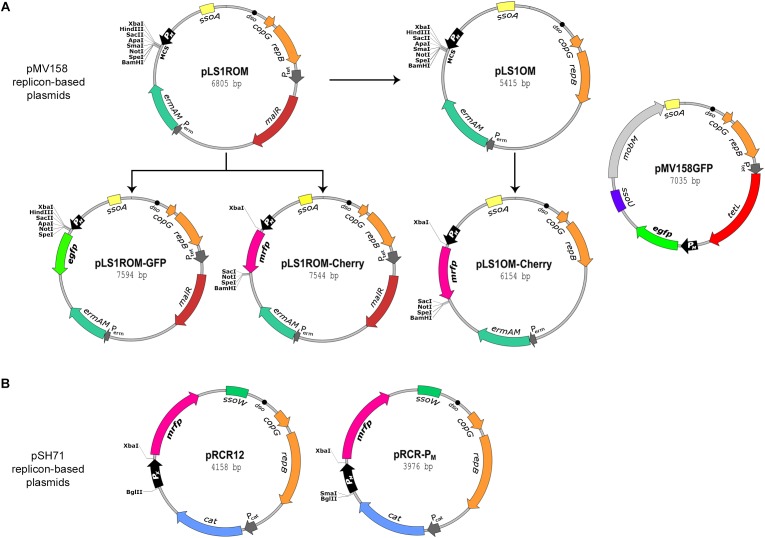
Maps of the plasmids used in this work. The plasmid vectors used in this work were grouped into those based on the pMV158 replicon (A) and those based on the pSH71 replicon (B). Both replicons belong to the same pMV158 family of RC plasmids. The essential components of the plasmid replicons are referred as dso, double strand origin of replication, and as copG and repB genes, which are involved in copy number control and replication, respectively. sso refers to single strand origin of replication of types A, U, and W. ermAM, cat, and tetL, refers to Ery, Cm, and Tc resistant markers, respectively. Promoter sequences PM, PX, Ptet, Pcat, and Perm are indicated by open arrows pointing in the direction of transcription. malR refers to the pneumococcal chromosomal gene encoding the MalR protein that, in the absence of maltose, represses transcription from PM and PX. mobM refers to the plasmid conjugative mobilization gene of pMV158. EGFP- and mCherry-encoding genes are indicated as egfp and mrfp, respectively. Restriction sites of the multicloning sequence (MCS) of pLS1ROM and pLS1OM vectors are indicated. Unique restriction sites in pLS1ROM-GFP, pLS1ROM-Cherry, and in pLS1OM-Cherry remaining after insertion of egfp or mrfp gene casettes in the corresponding MCS are also indicated. Maps of pRCR12 and pRCR-PM vectors include unique restriction sites of the MCS flanking the sequence of promoters PX or PM, respectively.